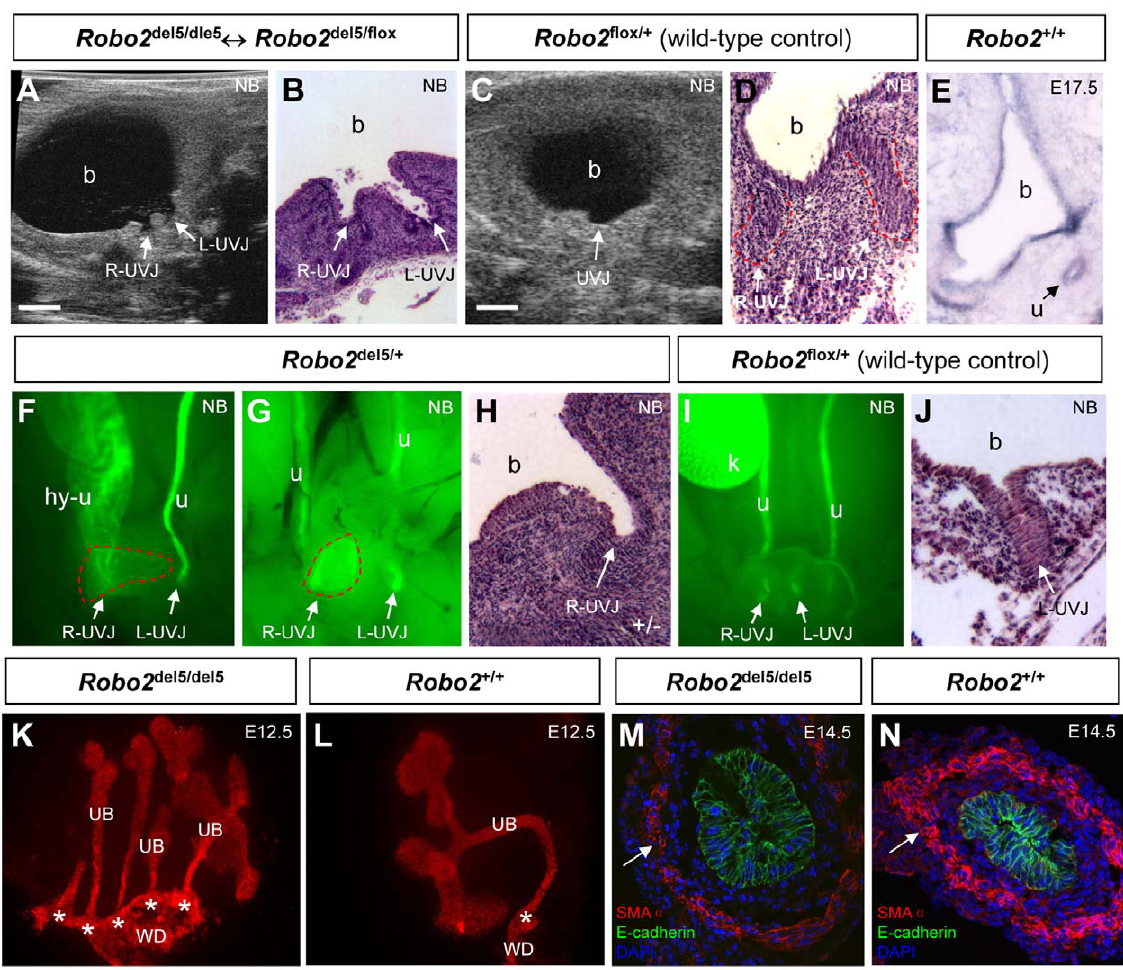
Figure 6. Fetal origin of antenatal hydronephrosis and VUR phenotype in Robo2 mutant mice. ( A ) Noninvasive in vivo ultrasound detection of bilateral golf-hole like ureterovesical junction (UVJ) dilatation (arrows) in a newborn Robo2 mosaic mouse (also see Video S7); Scale bar, 1.0 mm; R-UVJ: right UVJ; L-UVJ: left UVJ; b: bladder. ( B ) H&E histology of the same newborn mice in (A) confirmed the bilateral golf-hole like UVJ dilatation (arrows); Magnification: 100 6 . ( C ) An un-dilated normal UVJ (arrow) was barely detectable under ultrasound scan in a wild-type control newborn mouse; Scale bar, 1.0 mm. ( D ) H&E histology of the same control newborn mice in (C) showing un-dilated right and left UVJs outlined by red dot line; Magnification: 100 6 . ( E ) In situ hybridization analysis showing Robo2 transcripts expressed around the developing UVJ: in the distal ureter (u, arrow) inside the bladder (b) wall of an E17.5 mouse embryo; Magnification: 50 6 . ( F – H ) Unilateral UVJ dilatation in Robo2 heterozygous newborn mice: (F,G) Hoxb7-GFP reporter gene positive Robo2 newborn heterozygotes showing unilateral right UVJ dilatation (red dot line in panel F,G), associated with right hydroureter (hy-u in panel F) or undilated ureter (u in panel G); the left UVJ in Robo2 newborn heterozygotes (L-UVJ in panel F and G) appeared normal; Magnification: 25 6 . (H) H&E histology confirmed right UVJ dilatation (arrow) in a Robo2 newborn heterozygote; Magnification: 100 6 . ( I , J ) Both right and left UVJ (arrows) of a wild-type newborn control appeared normal by Hoxb7-GFP (panel I) or H&E histology (panel J) analyses; Magnification: 25 6 for panel I, 100 6 for panel J. ( K ) Early multiple ureteric buds (UB) outgrowth from the Wolffian duct (WD) in a Robo2 del5/del5 homozygous embryo (E11.5 kidney cultured for 1-day and stained with pan-cytokeratin); magnification: 60 6 . A wild-type embryo in ( L ) showing a single UB with one budding site (asterisk) from the Wolffian duct (WD); magnification: 60 6 . ( M , N ) Anti-smooth muscle a actin antibody (SMA a , red) showing reduced and irregular ureteral smooth muscle staining (arrow in M) in an E14.5 Robo2 del5/del5 homozygous embryo compared with its wild-type littermate control (arrow in N). The urothelium (stained by anti-E-cadherin antibody, green) appeared normal in both Robo2 del5/del5 homozygous and wild-type controls; DAPI (blue) marked cell nuclei; Magnification: 400 6 .